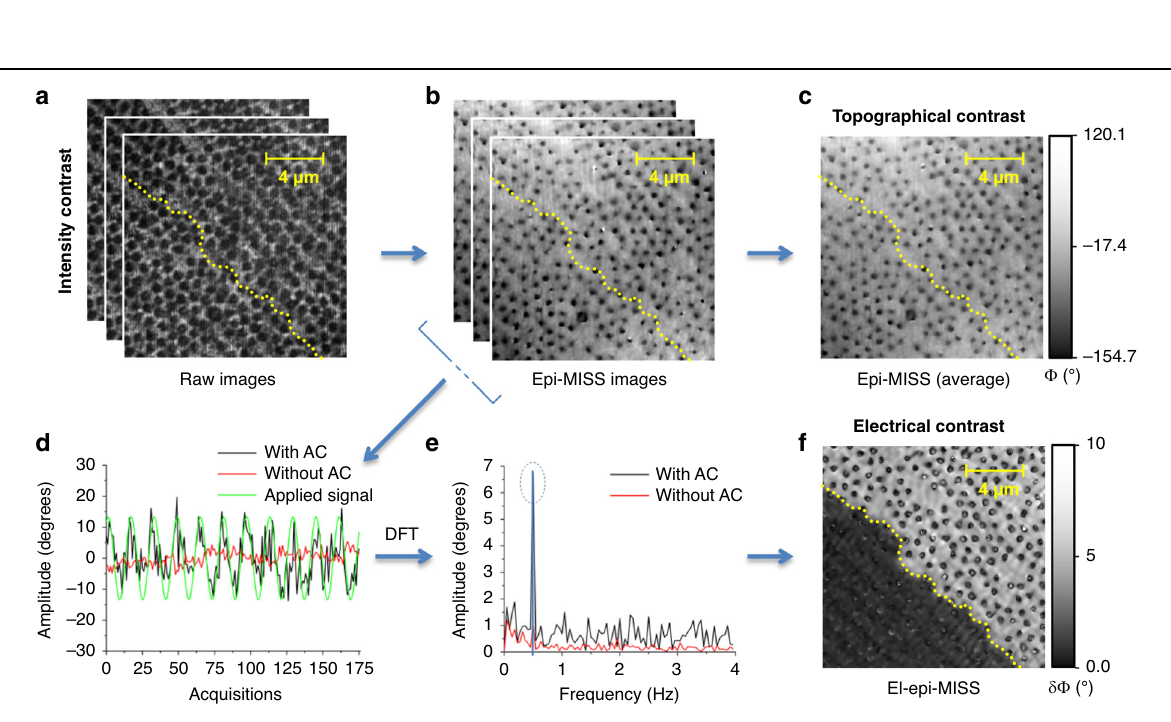
Optimized protocol to derive 2D maps with topographical